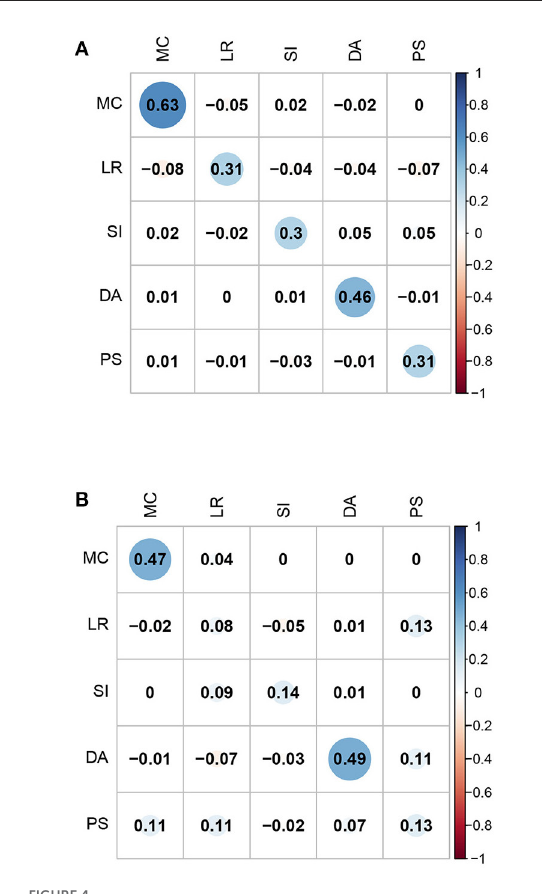
FIGURE4 Correlation coefficients between the five domain-specific abilities of the FIBF model and those of the between-item MIRT model. MC, mathematical computation; LR, logical reasoning; SI, space imagination; DA, data analysis; PS, problem solving. (A) Fourth grade. (B) Eighth grade.